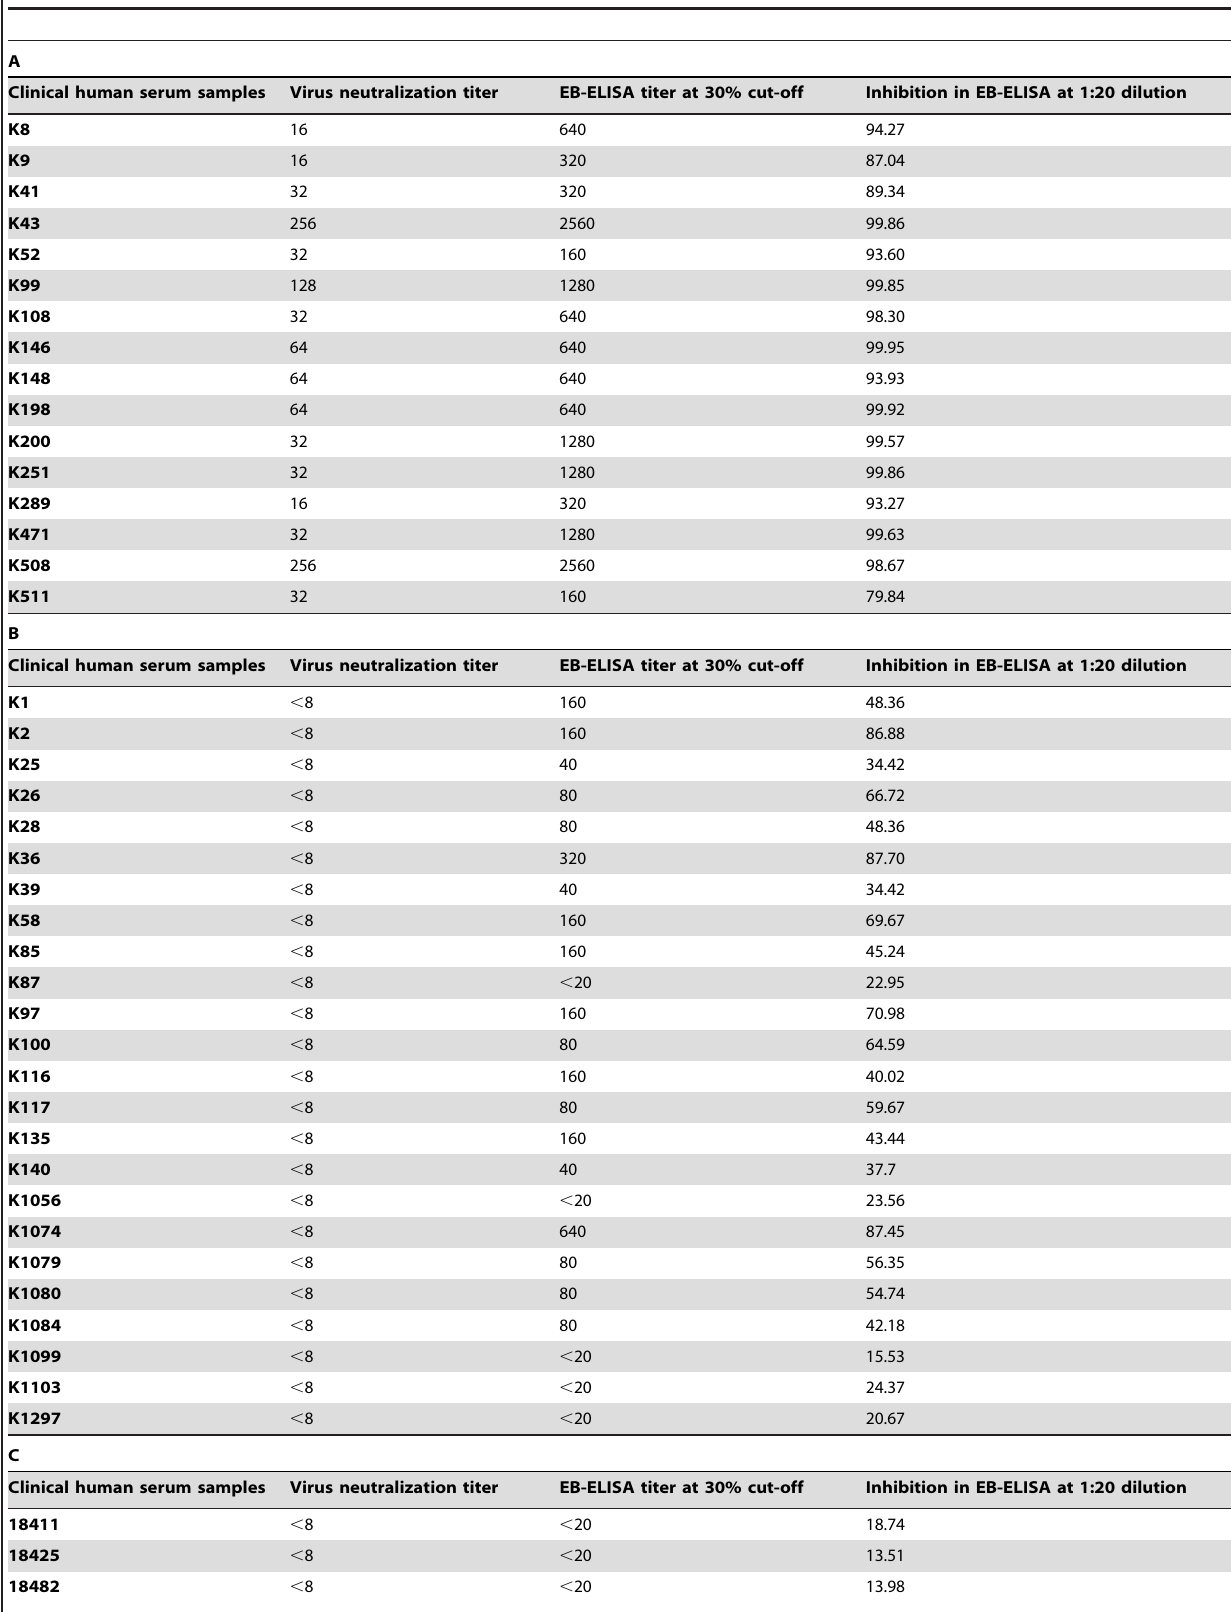
Table 4. Analysis of human serum samples in EB-ELISA. A. Human serum samples with positive titer in virus neutralization. B. Human serum samples with negative titer in virus neutralization. C. Human cord blood samples.